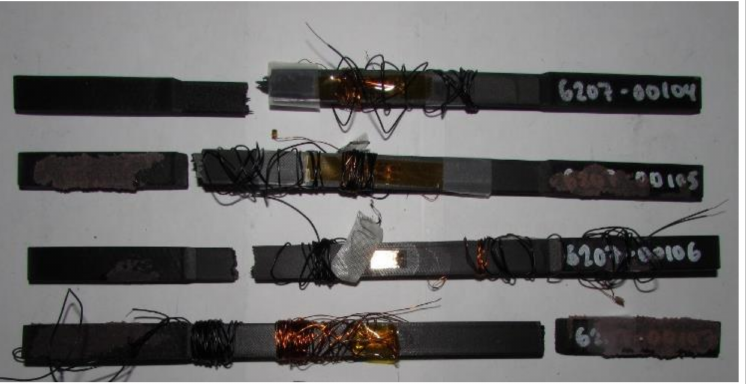
Figure 6. Failure modes of tested coupons from the RTD multifunctional electro-tensile